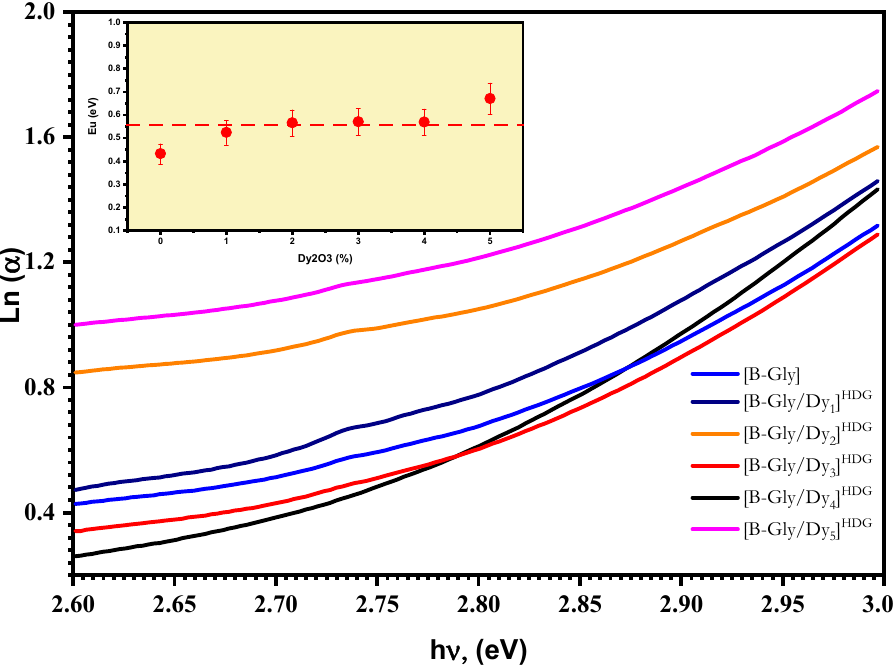
Figure 5. The plot of ln( α ) with h ν of glass samples; inset shows the Eu as a function of Dy 2 O 3 con-